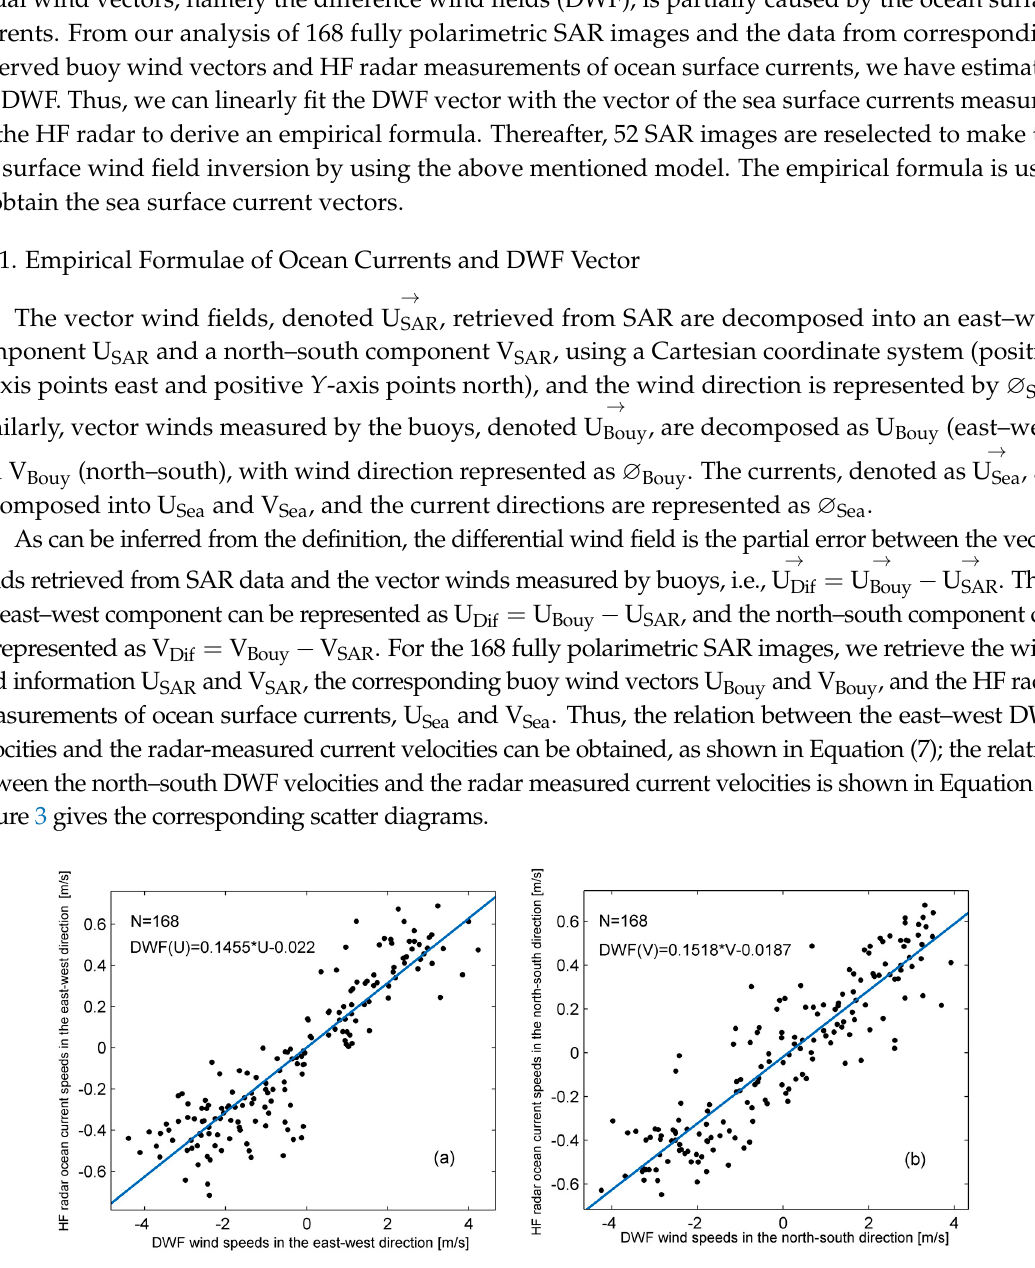
Figure 3. Scatter diagrams between the DWF velocities and HF radar ocean current velocities, in which, U and V represent the east–west and the north–south DWF velocities, respectively; DWF(U) and DWF(V) represent the east–west and the north–south ocean surface current velocities measured by the HF radar.